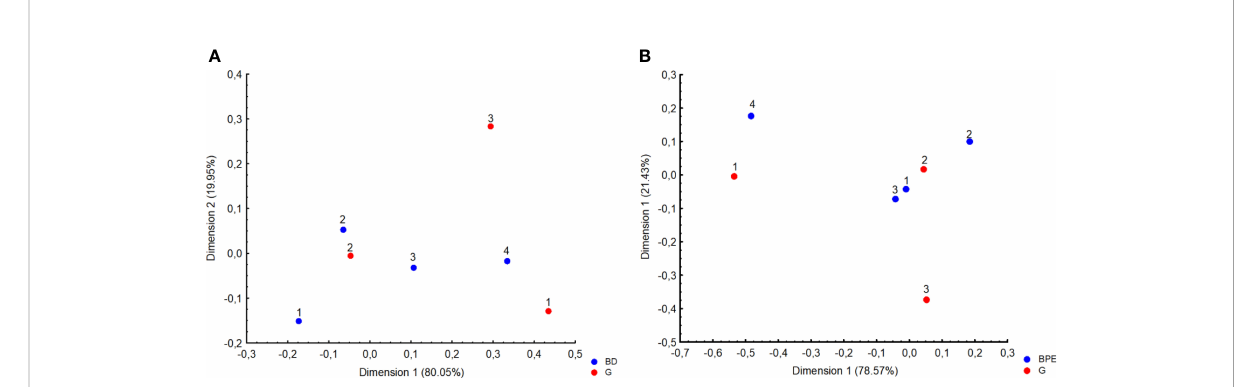
FIGURE 3 Correspondence analysis plot of the data which is a two-dimensional representation of grading (G) and (A) Breast Density (BD 1, almost entirely fat; 2, scattered fi brograndular tissue; 3, heterogenous fi brograndular tissue; 4, extreme fi brograndular tissue), as well as (B) background parenchymal enhancement (BPE).